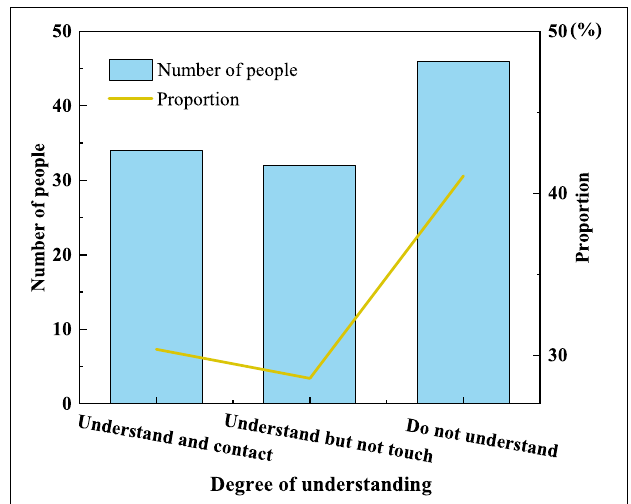
FIGURE 7 | Parents’ understanding of AR technology.